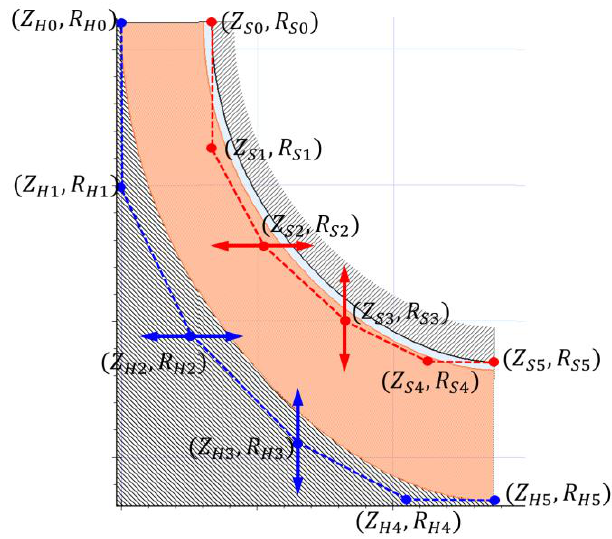
Figure 9. Hub and shroud meridional contours controlled by Bezier curves.